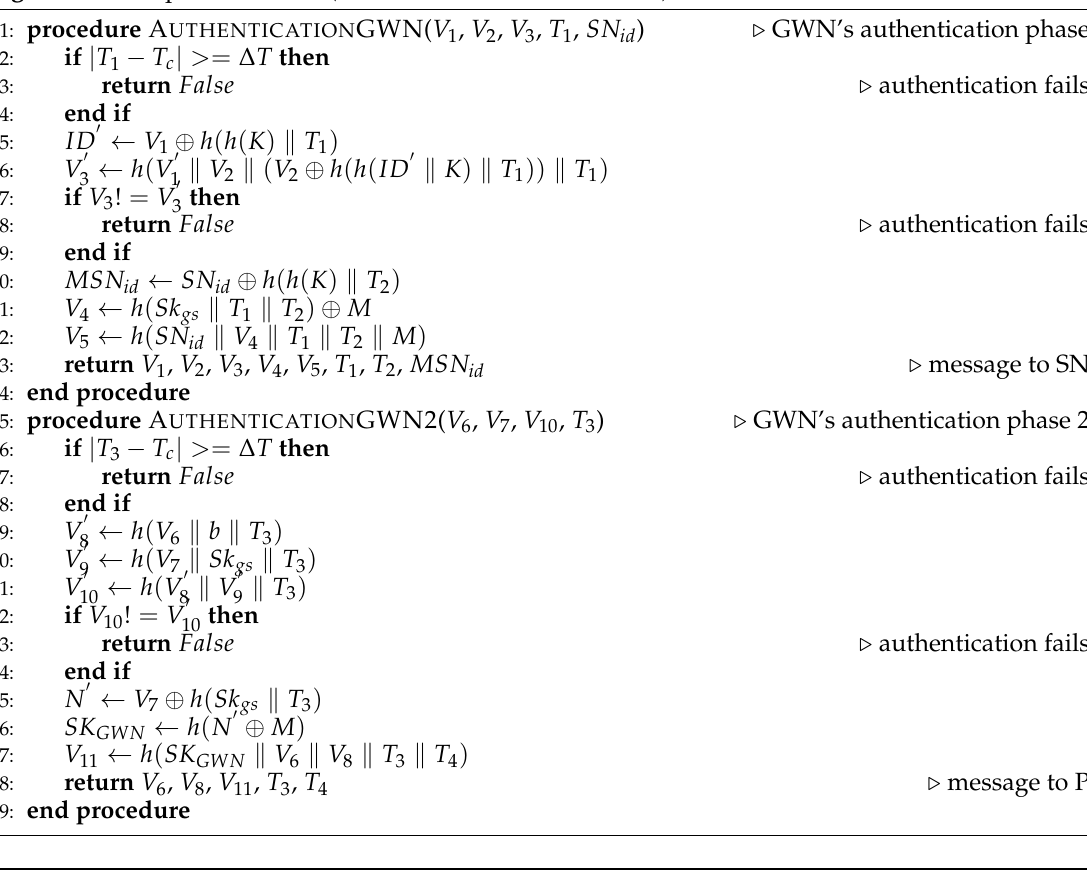
Algorithm 5 Proposed Scheme (GWN’s Authentication Phase)